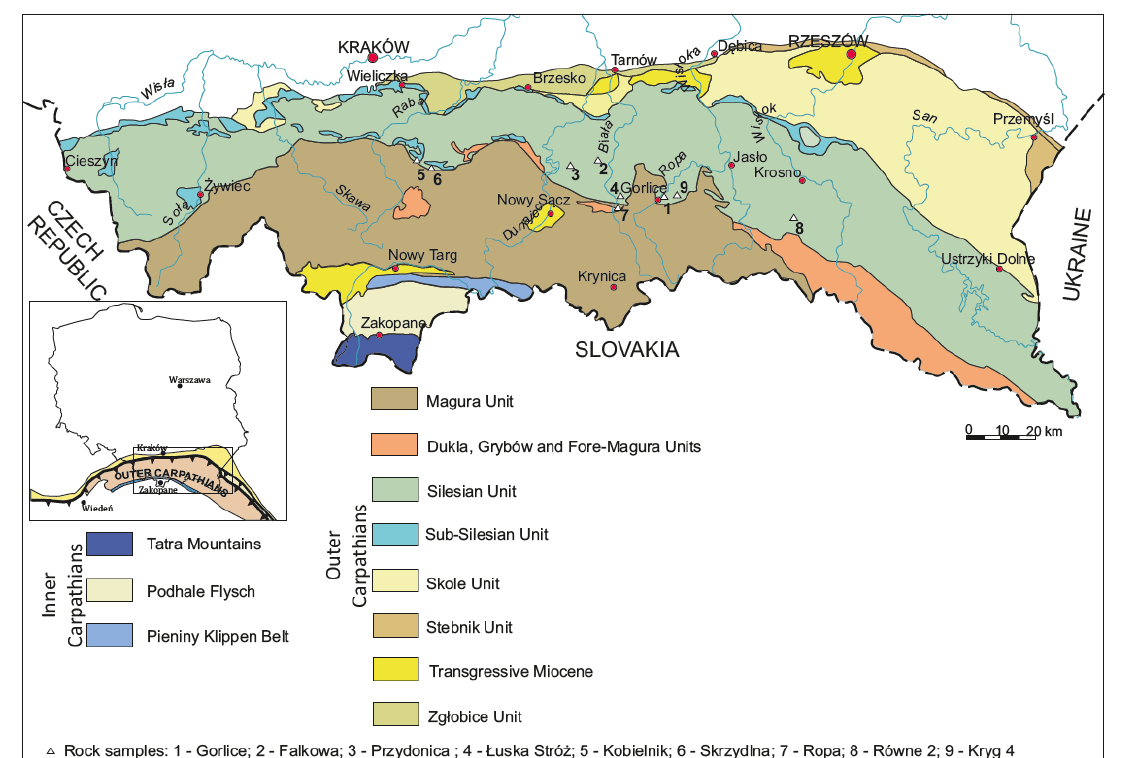
Figure 1. Geological sketch map (modified after Żytko et al. [30]).